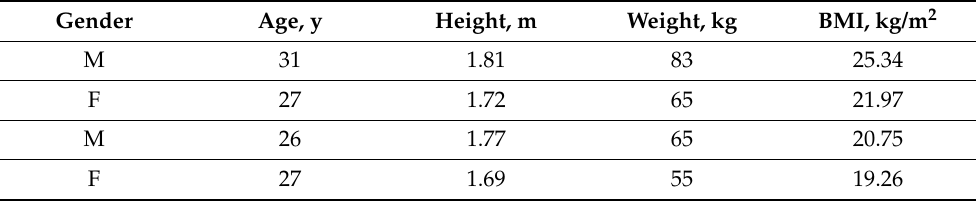
Table 1. The description of subjects participating in the experiment.